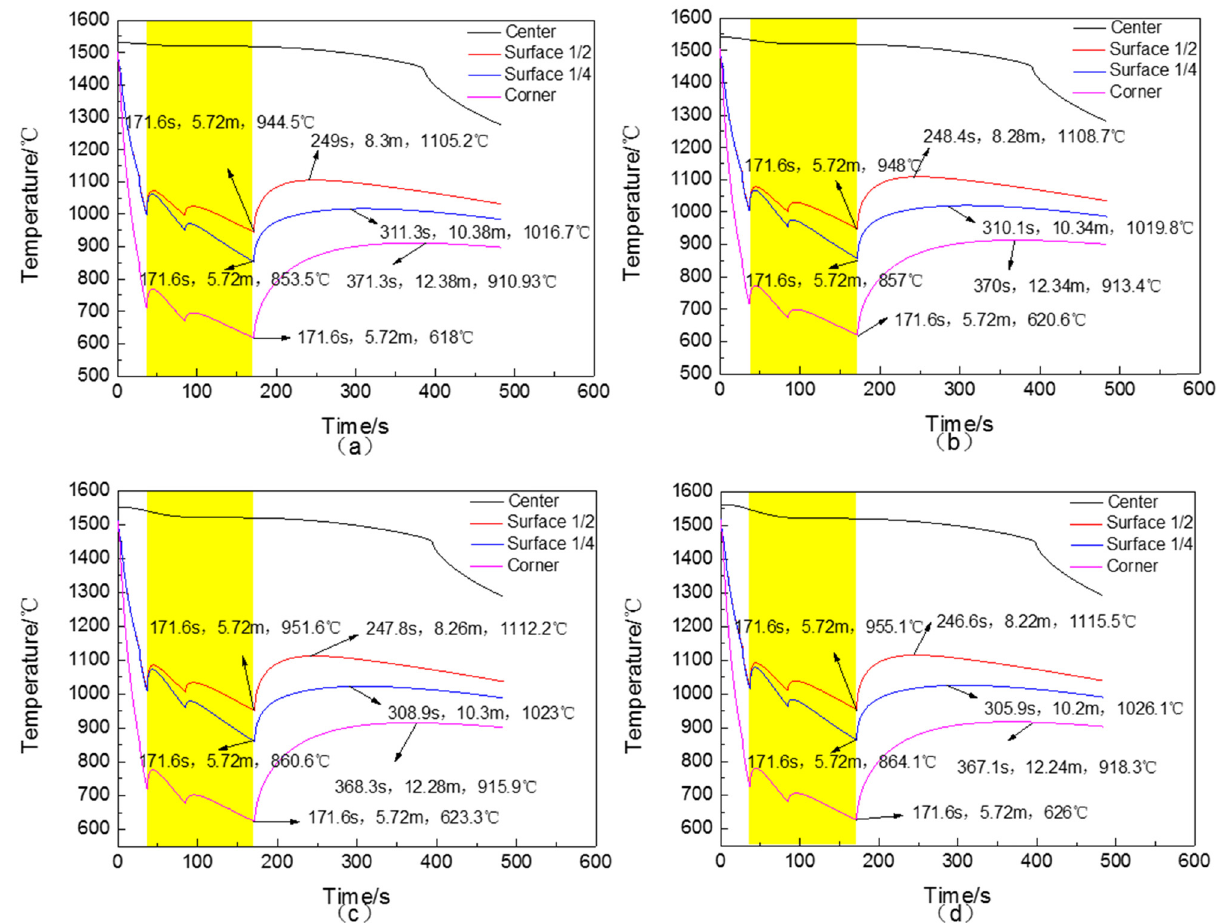
Figure 5: Variation of billet temperature under di ff erent superheat: ( a ) 10°C, ( b ) 20°C, ( c ) 30°C, and ( d )